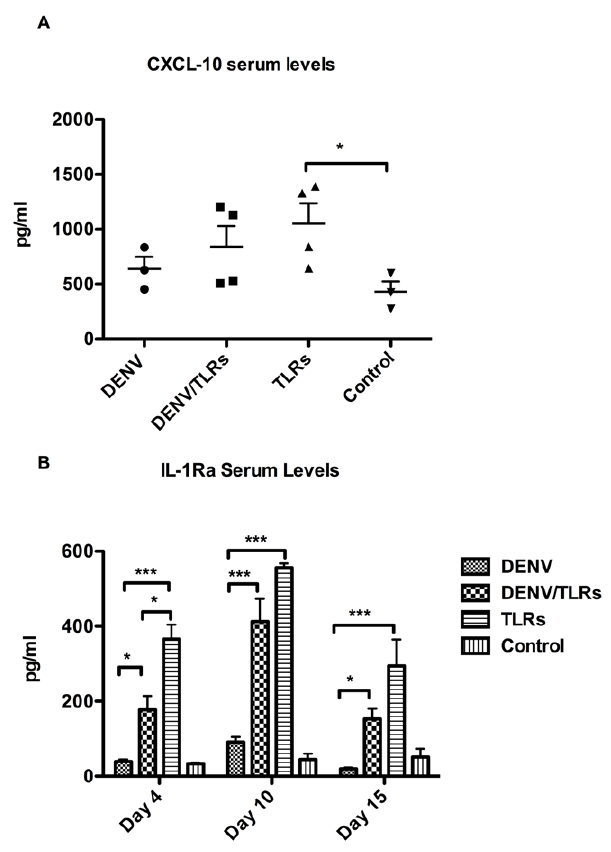
Figure 3. Serum levels of CXCL-10 and IL-1Ra are increased significantly after TLR stimulation and are inhibited by DENV. A: Coincident with the higher level of mDC activation, serum levels of CXCL-10 increased significantly only in the TLR group when compared to the Control group. Higher levels, albeit not significant, were also found in the DENV/TLR group. The lowest levels among the experimental groups were found in animals of the DENV group. This trend in the serum levels of CXCL-10 among different groups confirms a stimulatory effect of the TLR agonist but at the same time suggests an inhibitory role of Dengue virus in the secretion of this cytokine. B: Serum levels of IL-1Ra peaked 48 hours after the first TLR stimulation. An inhibitory effect of DENV at this time point (also coincident with the viremia peak) is supported by significantly higher values of this cytokine in the TLR group when compared to the DENV and DENV/TLR groups. Both groups, DENV/TLR and TLR, showed significantly higher serum levels of this cytokine when compared to the DENV and Control groups. Ten days after the infection (72 hours after second TLR stimulation), IL1- Ra values were still increased in both groups receiving TLR agonists. Significantly higher levels were present up to 15 days after the infection (8 days after the last TLR stimulation). However, at the later time point, there was no significant difference between the DENV/TLR and TLR groups. Asterisks denote significant differences, (*) p , 0.05, (**) p , 0.01, and (***) p , 0.001.